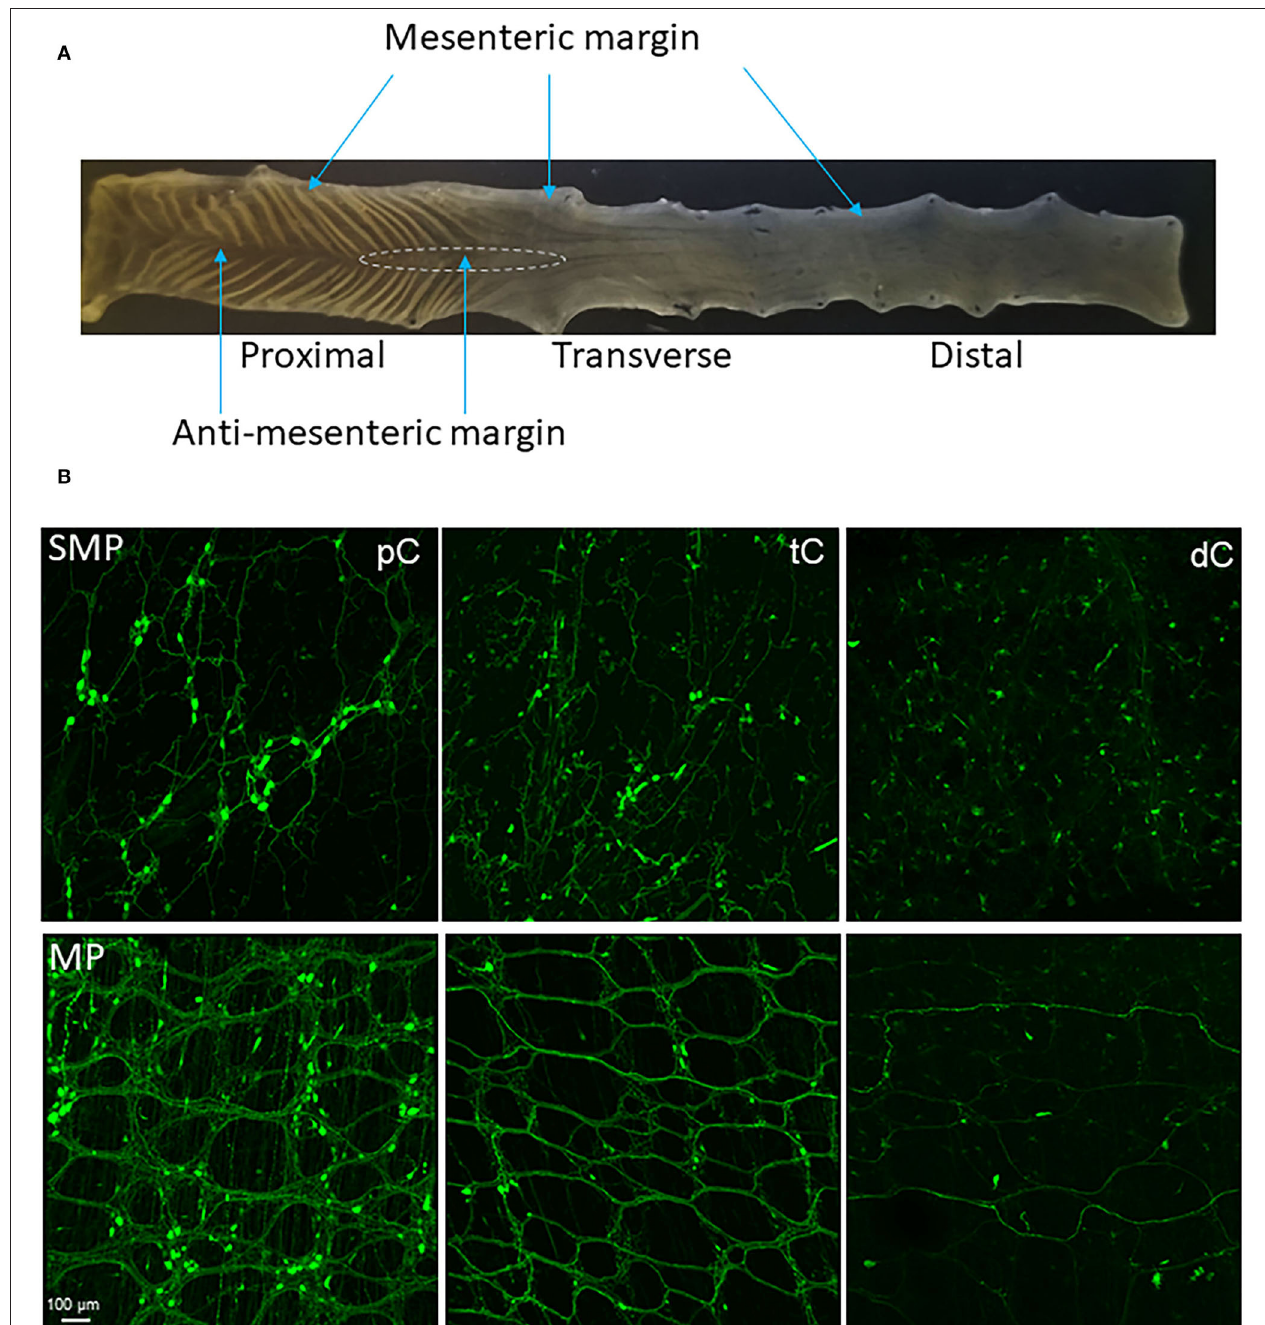
FIGURE 1 | (A) Segments and regions of an adult mouse colon. The specimen was opened along mesenteric margin with mucosa on the top. The proximal colon had mucosa folds aligned diagonally on each side and each fold ended at the antimesenteric margin. The proximal and transverse colon could be divided by the disappearance of the mucosa folds. There is no clear landmark between the transverse and distal colon. About 1.5cm caudal the proximal colon could be the transverse colon. The area marked by a dashed line is a hypoganglionic region in the antimesenteric margin located at the aboral end of the proximal colon and oral segment of the transverse colon. (B) Segmental difference: representative photomicrographs of AAV9 transduction in the mouse colon. AAV9-CAG-GFP was retro-orbitally injected at 3.3 x 10 11 GC/mouse 3 weeks before. AAV9-labeled the enteric neurons and nerve fibers were abundant in the proximal colon (pC), reduced in the transverse colon (tC) and only a few nerve fibers in the distal colon (dC). Upper row: submucosal plexus (SMP); lower row: myenteric plexus (MP). Scale: 100 µ m, same for all panels.